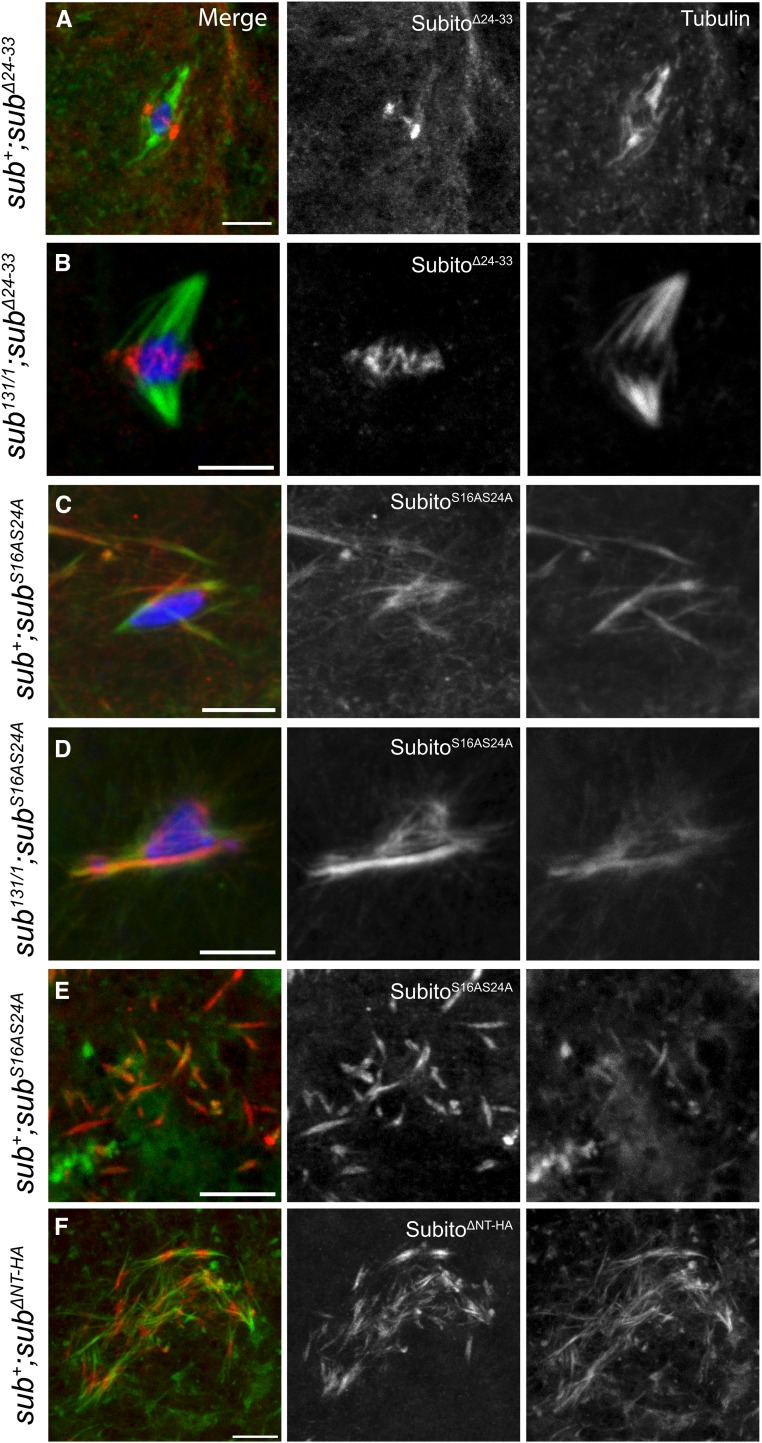
Conserved domains in the N-terminus are dispensable for meiosis but regulate ectopic microtubule bundling in ooplasm. Oocytes stained for DNA (blue), HA (red), tubulin (green). Single channels for HA and tubulin are shown in white. Scale bars are 5 µm. A, B. Localization of SubitoΔ(24-33) in sub+ or sub131/1background. SubitoΔ(24-33) shows normal localization. C, D. Localization of SubitoS16AS24A in sub+ or sub131/1background. (n= 21, 5, 22 and 5 respectively for panels A-D). E, F. Examples of ectopic microtubule bundling in oocytes expressing SubitoS16AS24A although it is not as severe as SubitoΔNT.